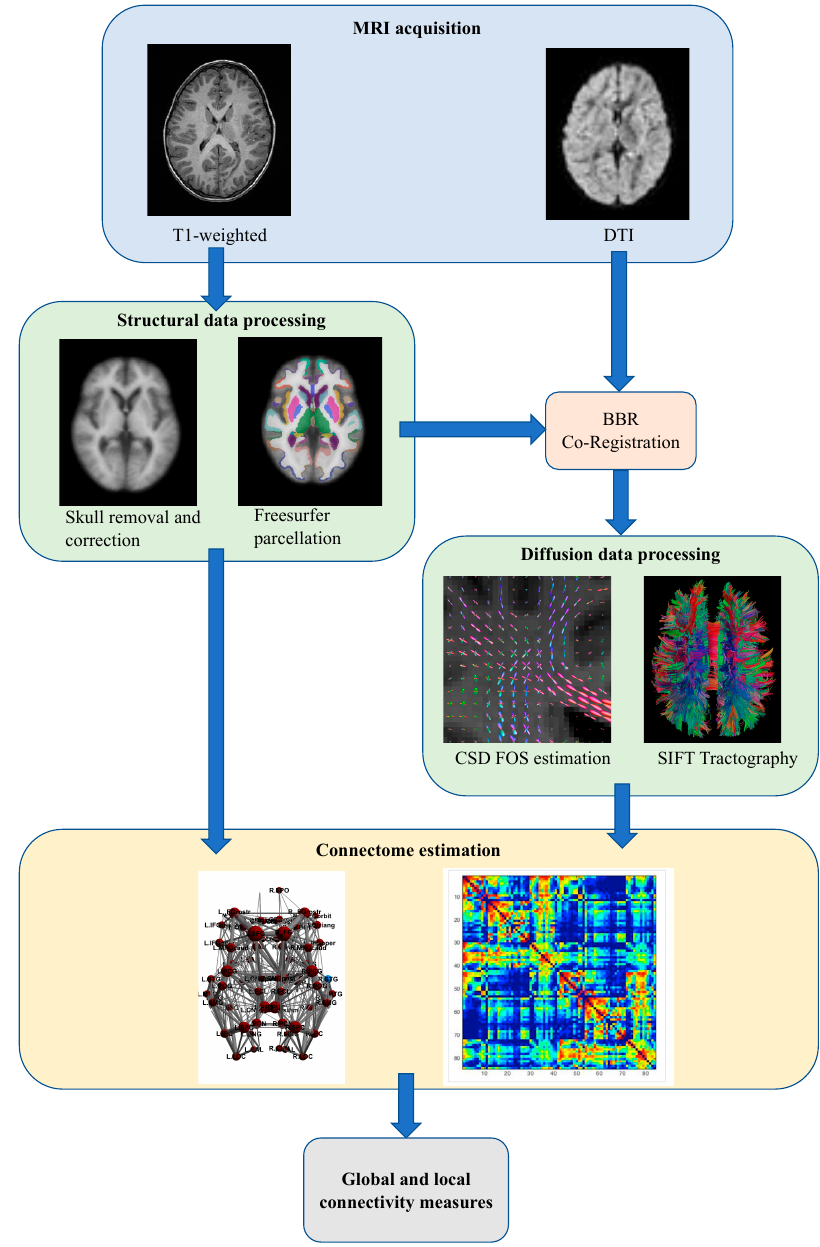
Figure 2. Overall schematic representation of the construction of the structural brain networks. BBR: Boundary-Based Registration; CSD: constrained spherical deconvolution; FOD: fiber orientation distribution; SIFT: spherical-deconvolution informed filtering of tractograms.